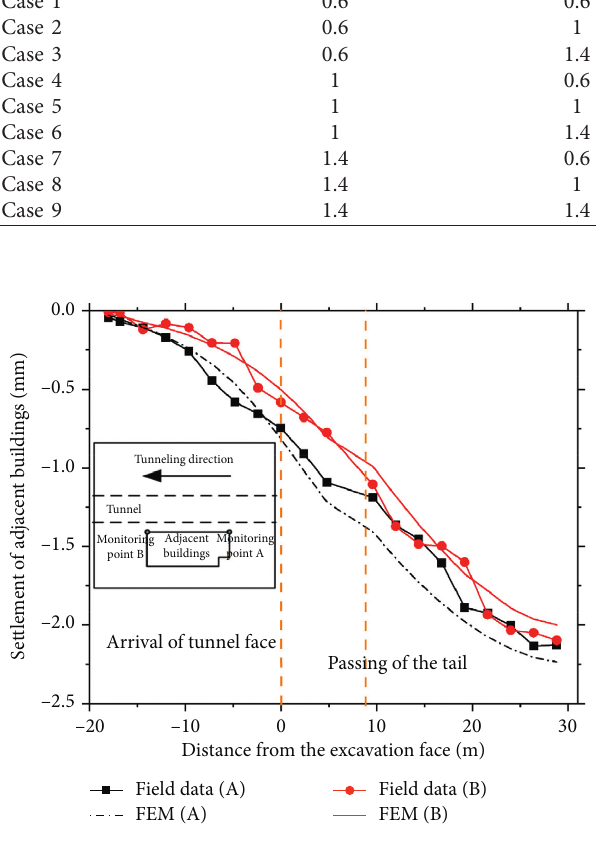
Figure 11: Comparison of settlement simulation and total station monitoring results of adjacent buildings.